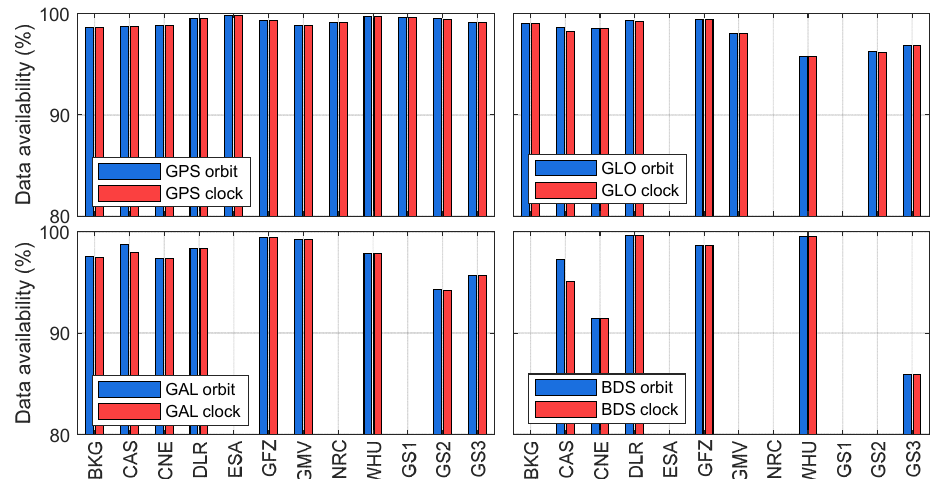
Figure 1. Epoch availability of SSR corrections during the experiment.